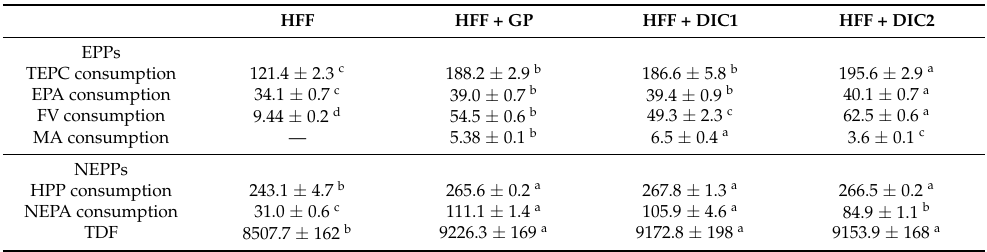
Results are expressed as mg/kg body weight/day and as means ± standard deviations. Values in the same row with different superscript letters differ significantly according to Tukey’s test ( p < 0.05). EPPs, extractable polyphenols; TEPC, total extractable phenolic compound; EPA, extractable proanthocyanidin; FV, flavonoid; MA, monomeric anthocyanin; NEPPs, non-extractable polyphenols; HPP, hydrolyzable polyphenol; NEPA, non-extractable proanthocyanidin; TDF, total dietary